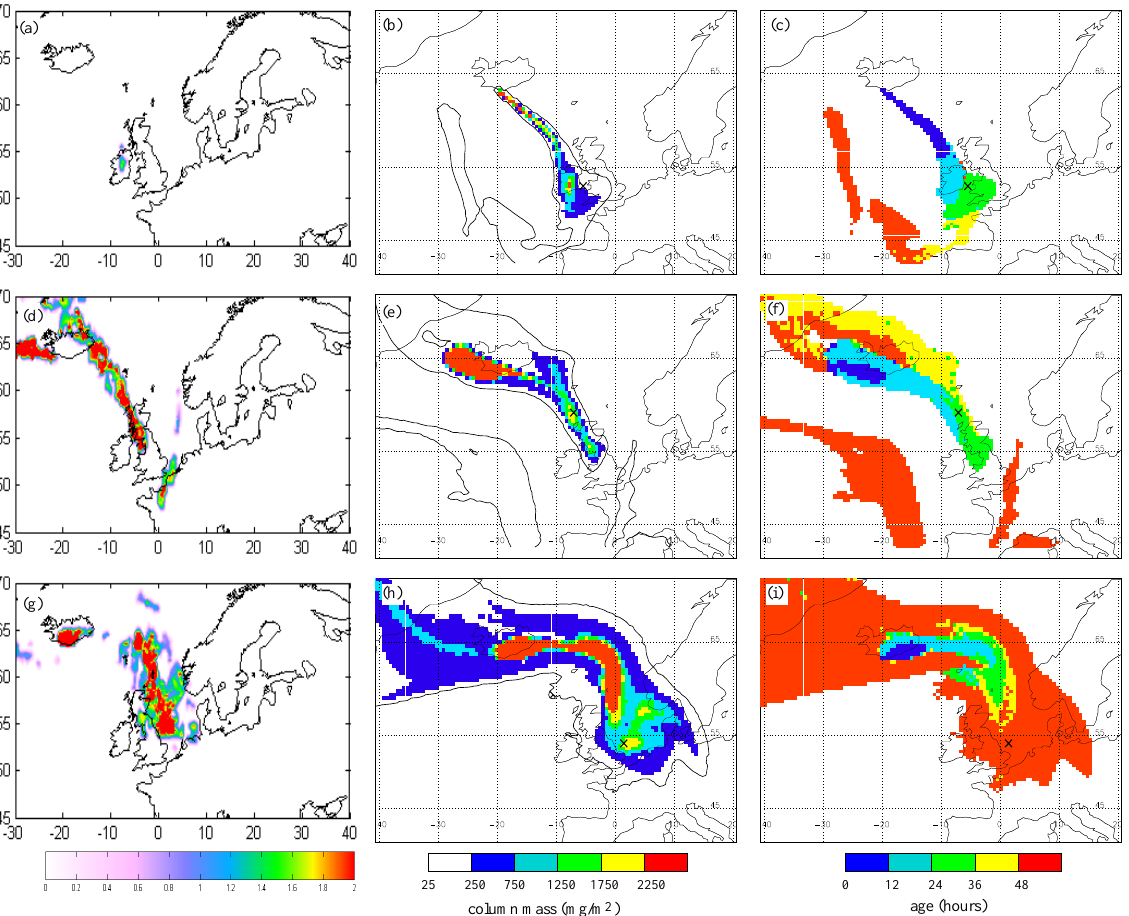
Fig. 7. (a) , (d) and (g) IASI measured volcanic ash index (K) at (a) 10:35UTC on 5 May, at (d) 10:49UTC on 14 May, and at (g) 09:46UTC on 17 May. (b) , (e) and (h) Column-integrated mass using distal particle size distribution 2 and a distal fine ash fraction of 4.5%. (c) , (f) and (i) Average age of the ash cloud at the height at which the maximum concentration in the column occurs. (b) and (c) at 12:00UTC on 5 May, (e) and (f) at 13:00UTC on 14 May, and (h) and (i) at 15:00UTC on 17 May. The cross shows the location of the aircraft observations.